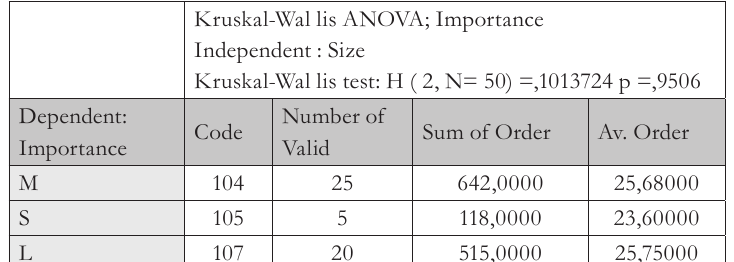
Tab. 6 – Kruskal-Wallis test, Importance and Size (Small, Medium, Large), Source: Own processing at STATISTICA, 2015